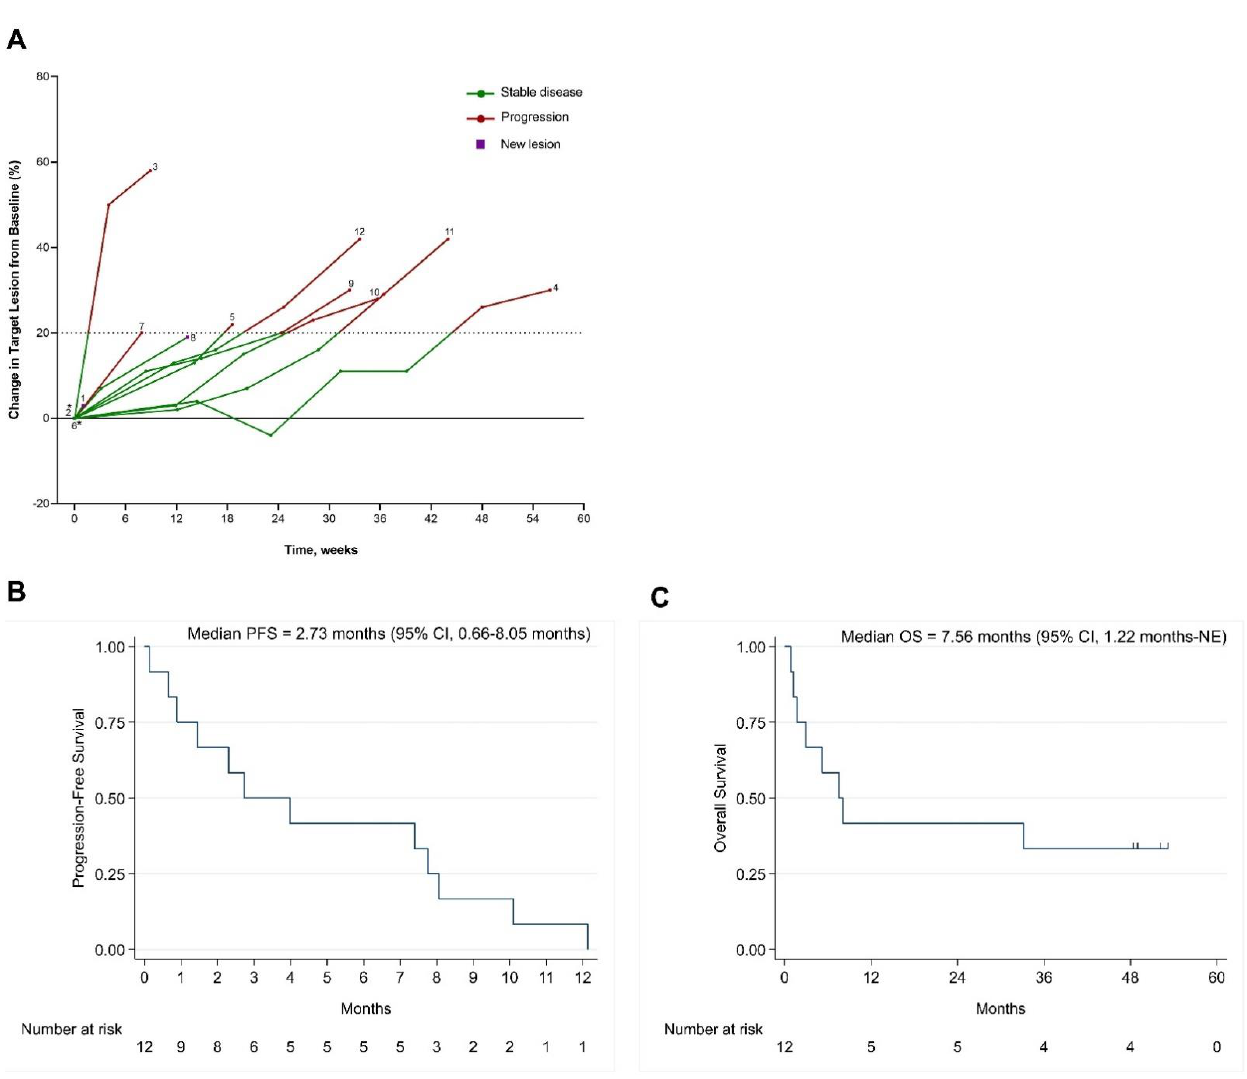
Figure 3. ( A ) Spider plot. Tumor growth or shrinkage from baseline in patients who underwent treatment with BBI608 and immunotherapy. Spider plot illustrates changes in lesion tumor burden and presence of new lesions over time. CT scan data at the most recent time prior to cycle 1, day 1 was chosen as baseline (time 0). The horizontal (x) axis shows time at restaging CT scans as weeks from baseline. The vertical (y) axis shows percentage of change in tumor measurement from baseline. Each line represents data from an individual patient and is labeled with the patient ID at the end. Each dot represents a data point collected at each restaging CT scan. The green lines represent stable disease. The red lines represent progressive disease (≥20% increase in tumor measurements from baseline), based on RECIST1.1. The square dot represents presence of new lesions. * Patients 02 and 06 discontinued treatment owing to toxicity before the completion of cycle 1 and did not have tumor assessment. ( B ) Kaplan–Meier curve for progression-free survival. ( C ) Kaplan–Meier curve of overall survival.